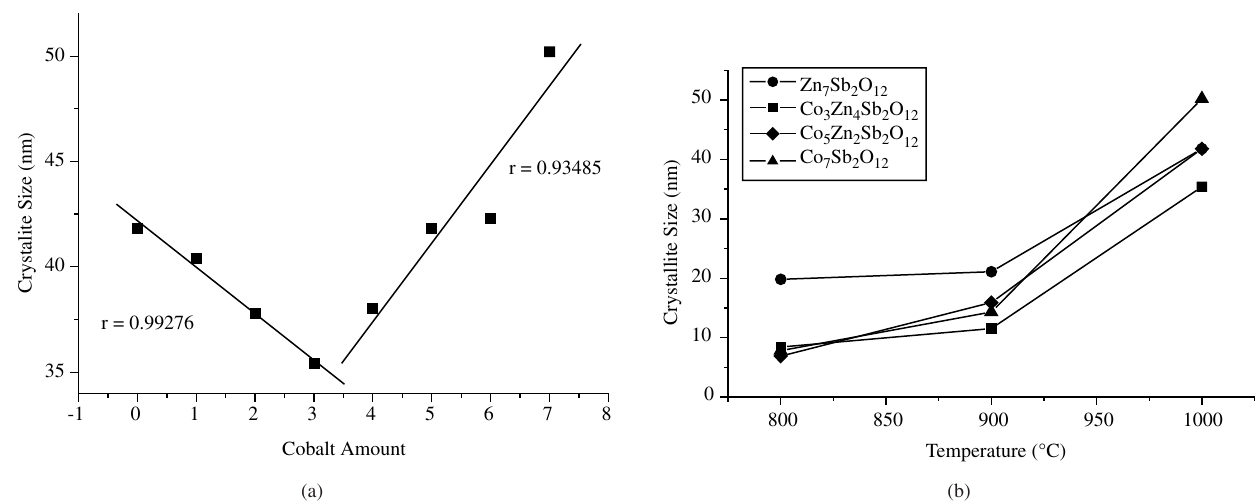
Figure 8. Crystallite size results: a) Variation as a function of cobalt amount, after calcination at 1000° C; b) Variation as a function of temperature.